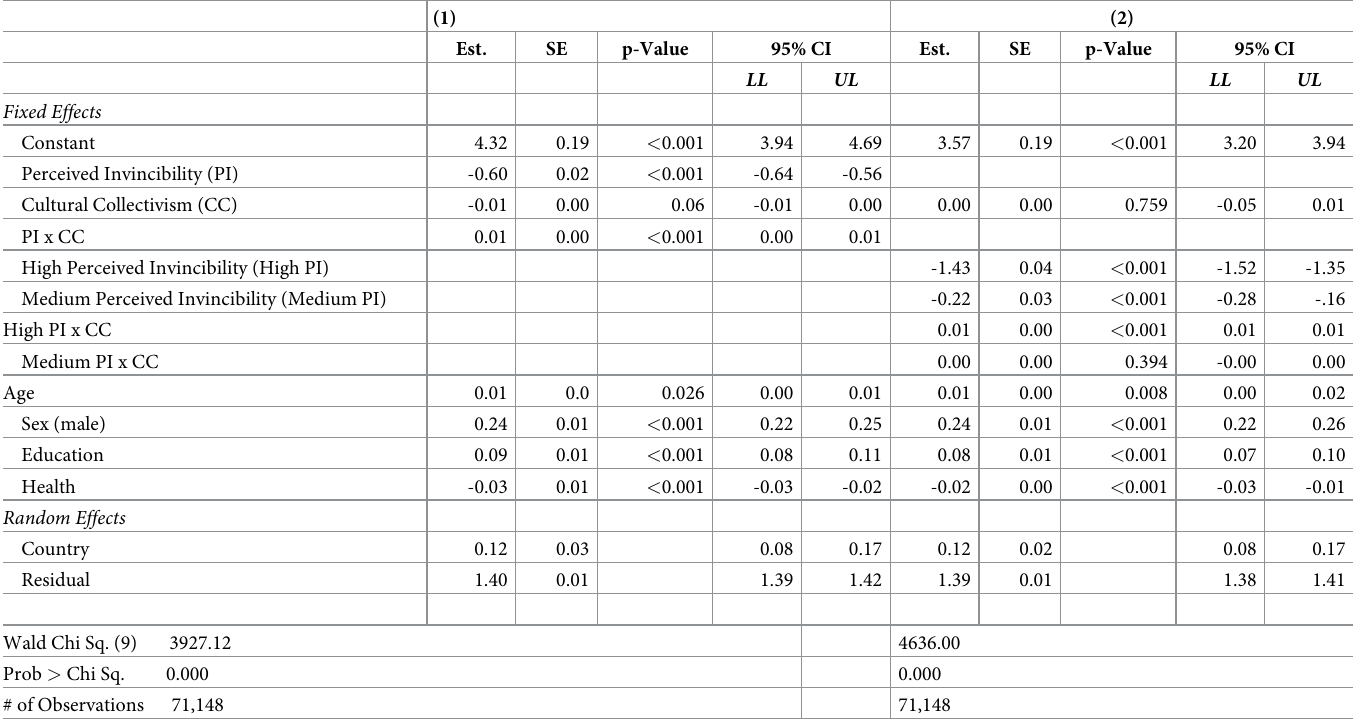
Table 2. Linear mixed model results for the effects of perceived invincibility and cultural collectivism on vaccination